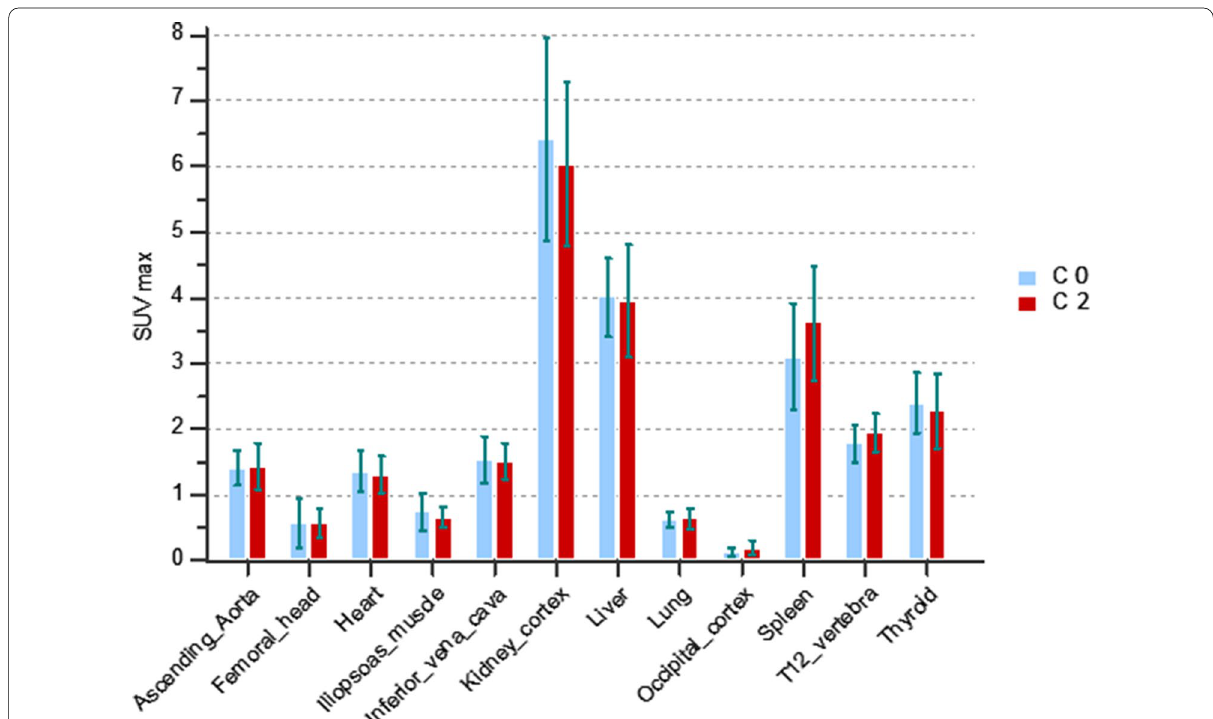
Fig. 1 SUV max uptake in organs before (C0) and after (C2)